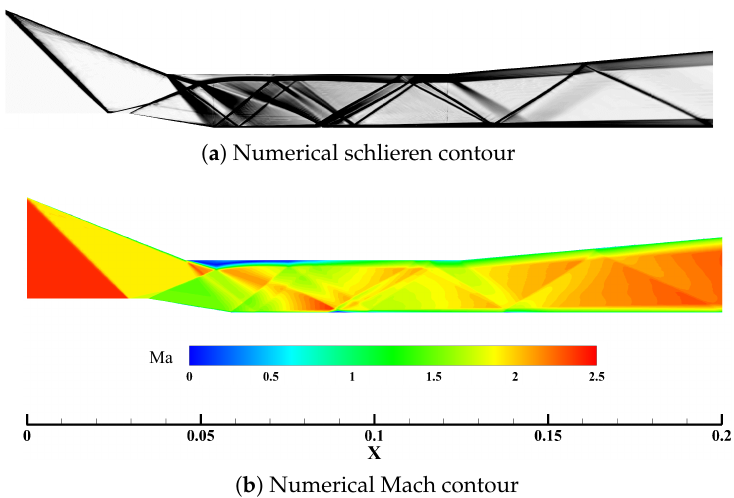
Figure 10. 5th WENO simulation